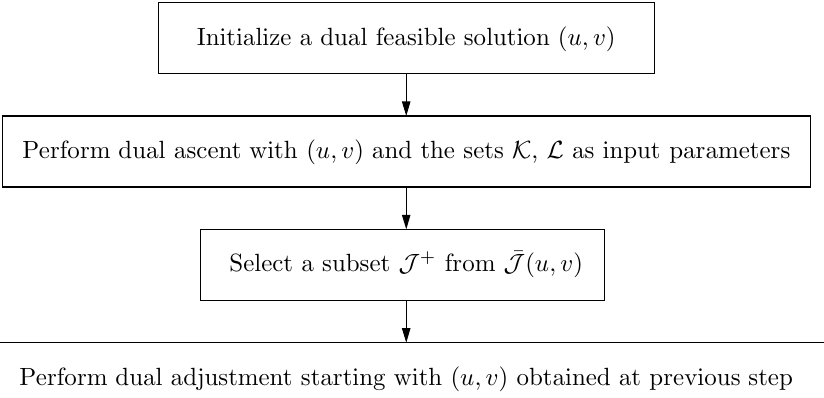
Figure 1: A procedure to produce near optimal solution of UFLP-SS. Algorithm 3 : A procedure to construct a subset